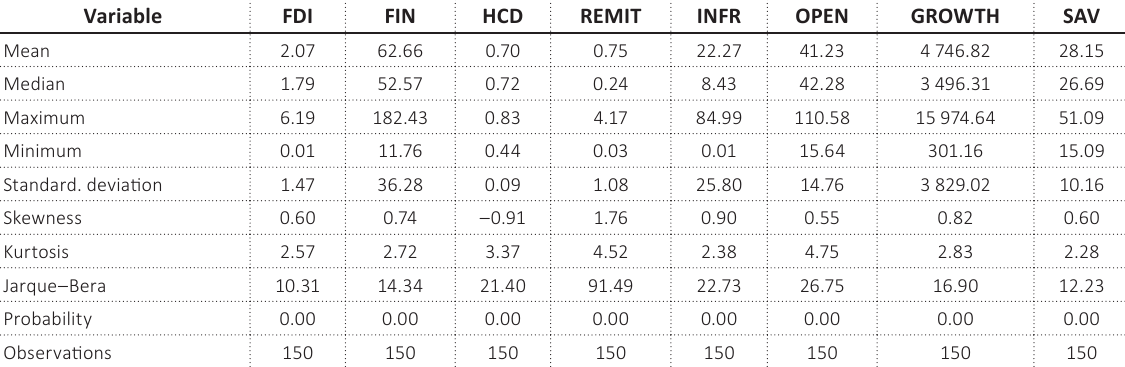
Table 3. Descriptive statistical analysis